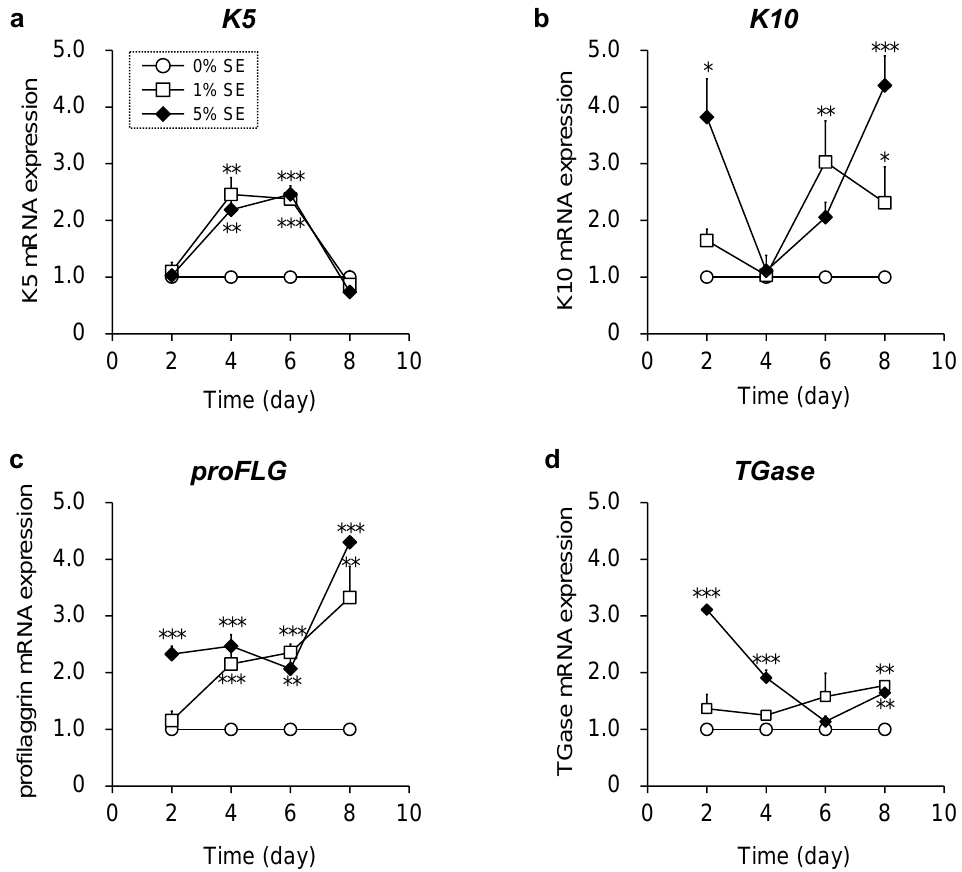
Figure 3. Effects of Shotokuseki extract on gene expression of differentiation markers in NHEKs. Cells were treated with Shotokuseki extract for 2 – 8 days. ( a ) K5, ( b ) K10, ( c ) proFLG, and ( d ) TGase mRNA expression were assessed by RT-qPCR. Each expression was normalized to the housekeeping gene, GAPDH. Data are expressed as mean ± S.D. of three independent experiments. * p < 0.05, ** p < 0.01, and *** p < 0.001 (compared with control group). Statistical significance was evaluated using the Dunnett’s multiple comparison